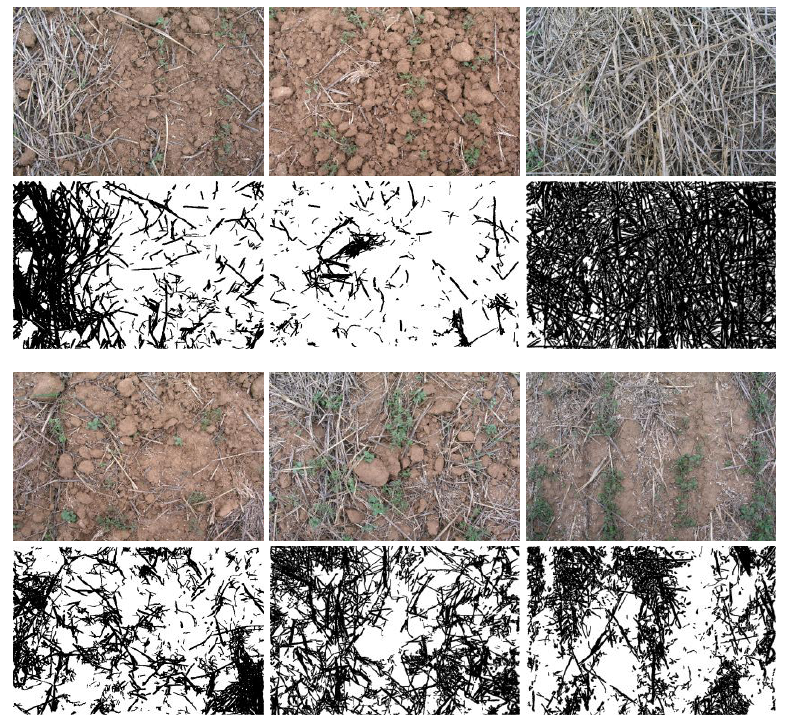
Figure 2. Images of sampled locations and binary template images manually produced by a